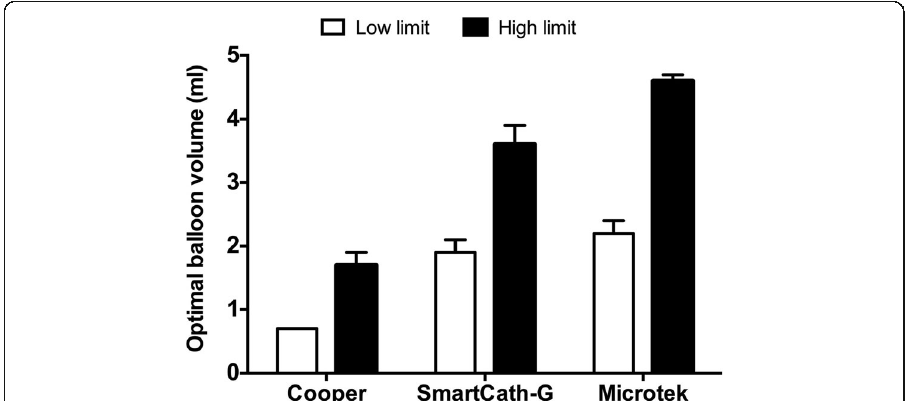
we estimated the optimal balloon volume and range using a sigmoid fitting of balloon pressure-volume curve, which has been used to predict the lower and upper inflection points in the respiratory system pressure-volume curve analysis [19, 20]. After normalization based on parameters of the regression equation, the dimensionless variables of balloon pressure and balloon volume were closely distributed along the standard sigmoid curve, and the mean residual for the dimensionless volume variables was minor (Additional file 1: Figure S1 and S2). More importantly, all measured P TM values at V and V were within ±1 cmH O (Fig. 5), which has been used as the MIN MAX 2 threshold in previous bench study [15]. Together, these results indicate that the sigmoid regression of balloon pressure and volume can be used to accurately estimate the opti- mal filling volume.